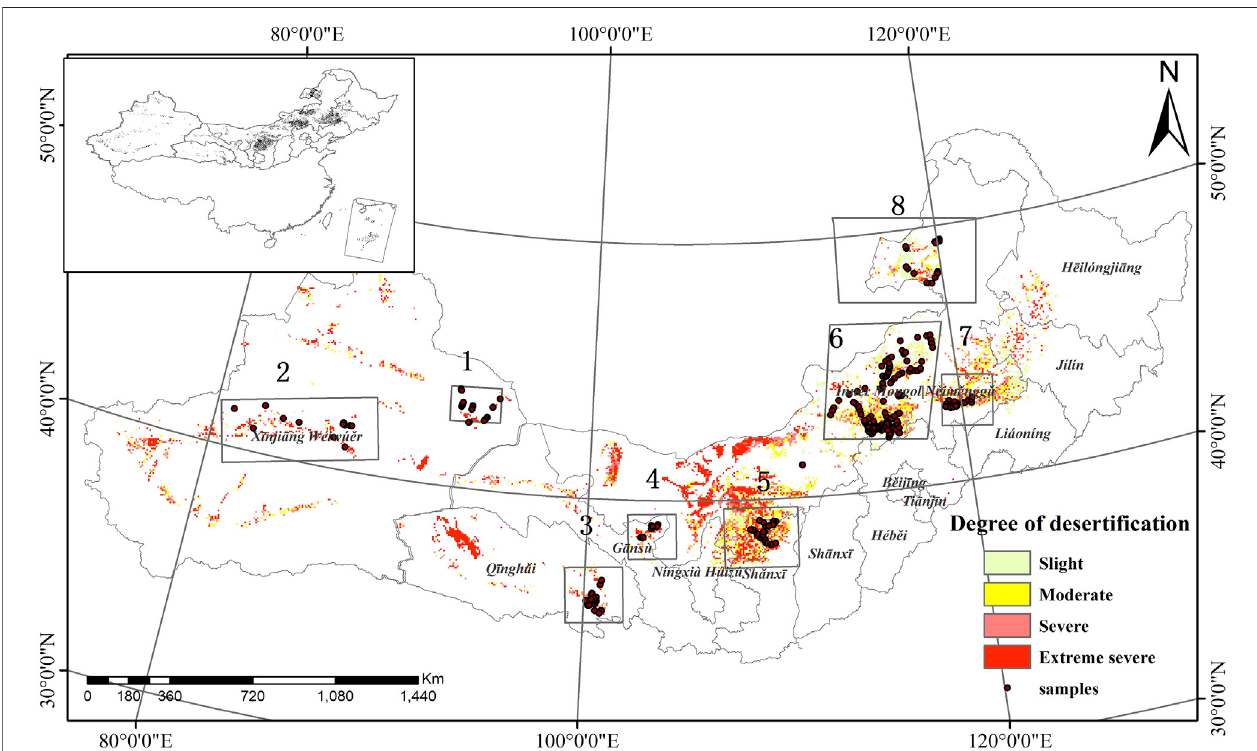
FIGURE 1 | Study area range and sampling locations (1: Gurbantunggut Desert, 2: Taklimakan Desert, 3: Gonghe alpine deserti fi ed grassland, 4: Minqin Oasis- Desert transition belt, 5: Mu Us Sandy Land, 6: Otindag Sandy Land, 7: Horqin Sandy Land, 8: Hulunbuir Sandy Land).